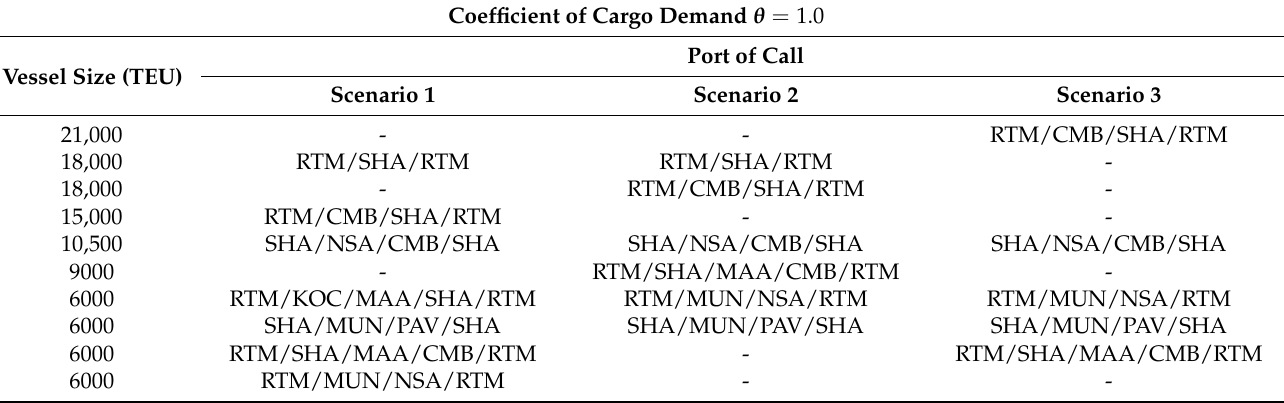
Table 6. Results of optimized services at θ = 1.0. Coefficient of Cargo Demand θ = 1.0